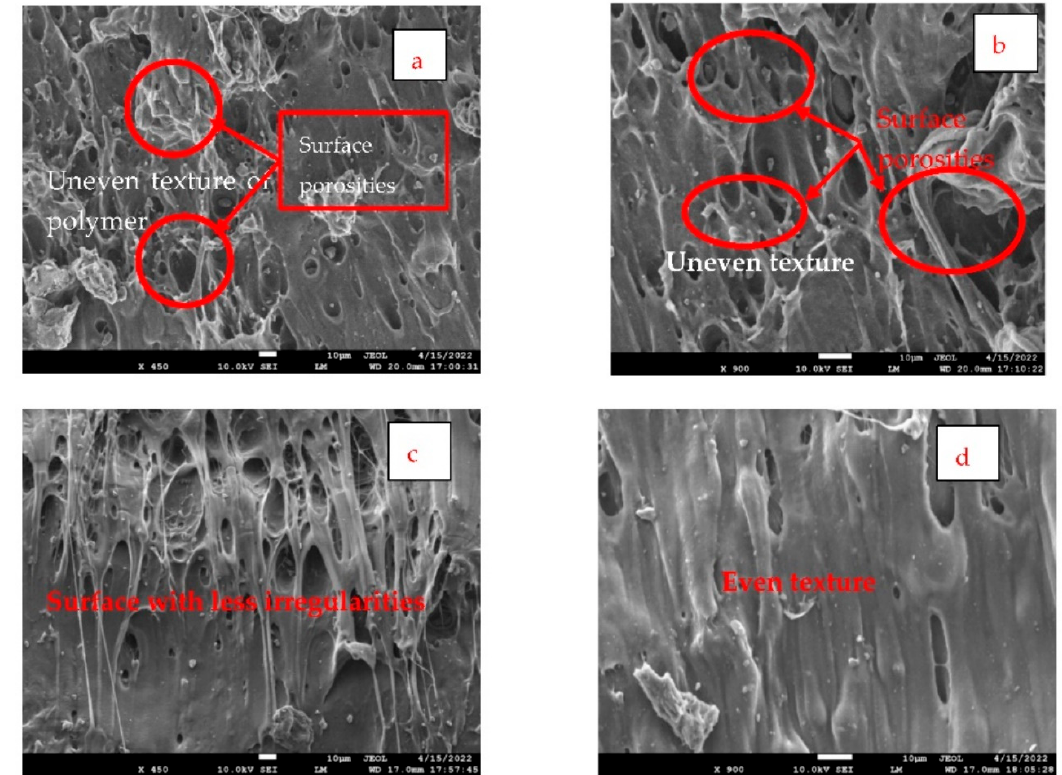
Figure 9. SEM images for sample 3 ( a ) at ×450 and ( b ) at ×900 and sample 8 ( c ) at ×450 and ( d ) at ×900.